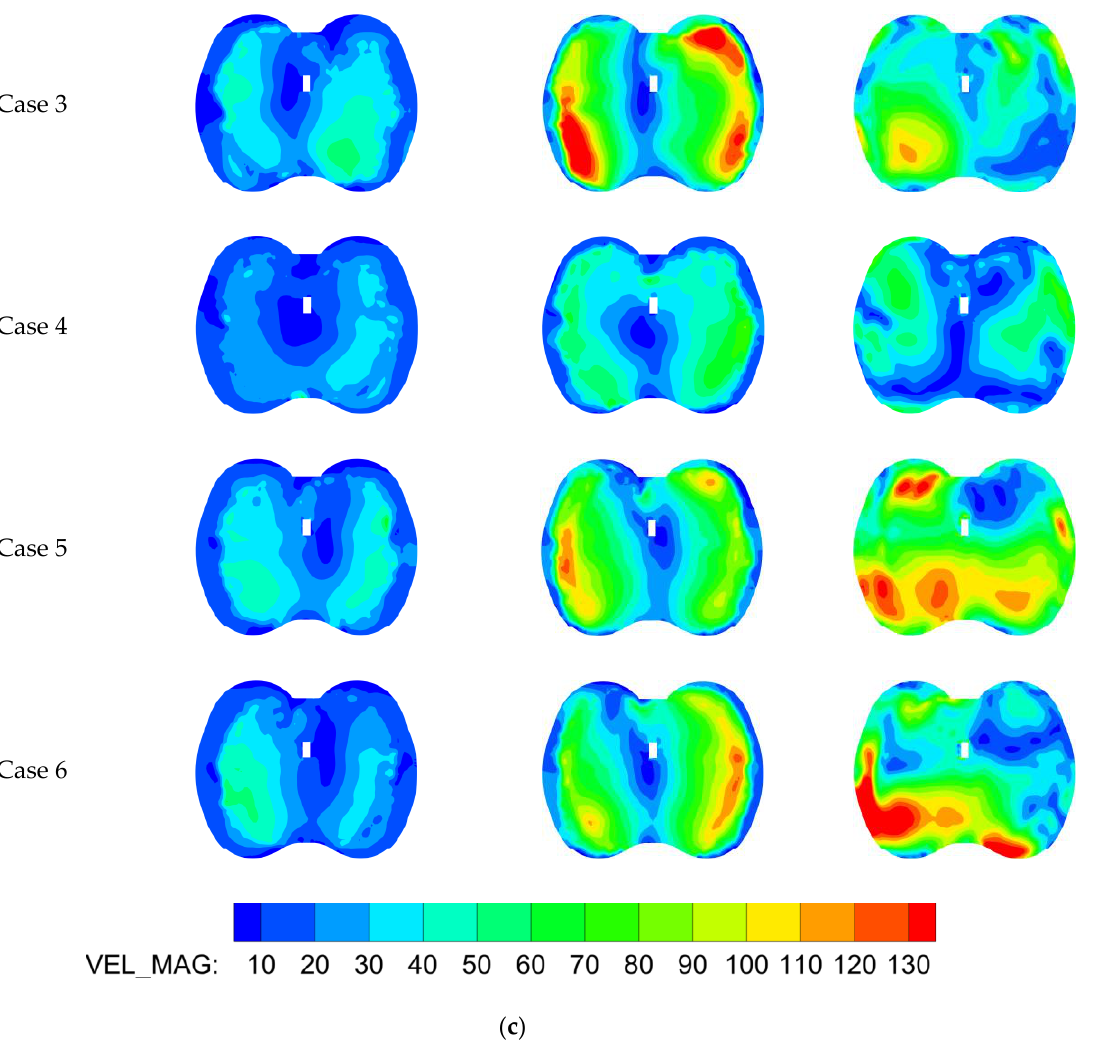
Figure 18. The mass fraction distribution of ( a ) CH 2 O and ( b ) HCO, and ( c ) velocity magnitude distribution in the cylinder in different water injection cases (CR = 10.3, ignition time = − 14 degCA).